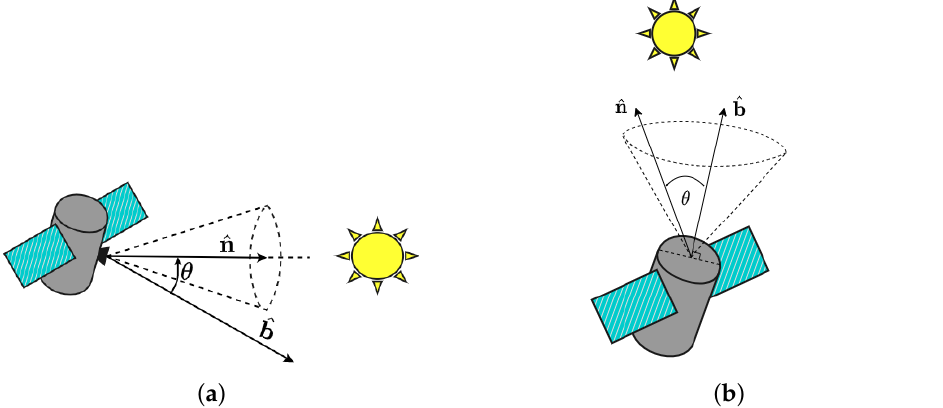
Figure 7. Static Pointing Constraints. The satellite in ( a ) has to keep its sensitive equipment from entering the exclusion cone defined by the sun while the satellite in ( b ) has an inclusion constraint defined by the sun while keeping its solar array pointed towards maximum power